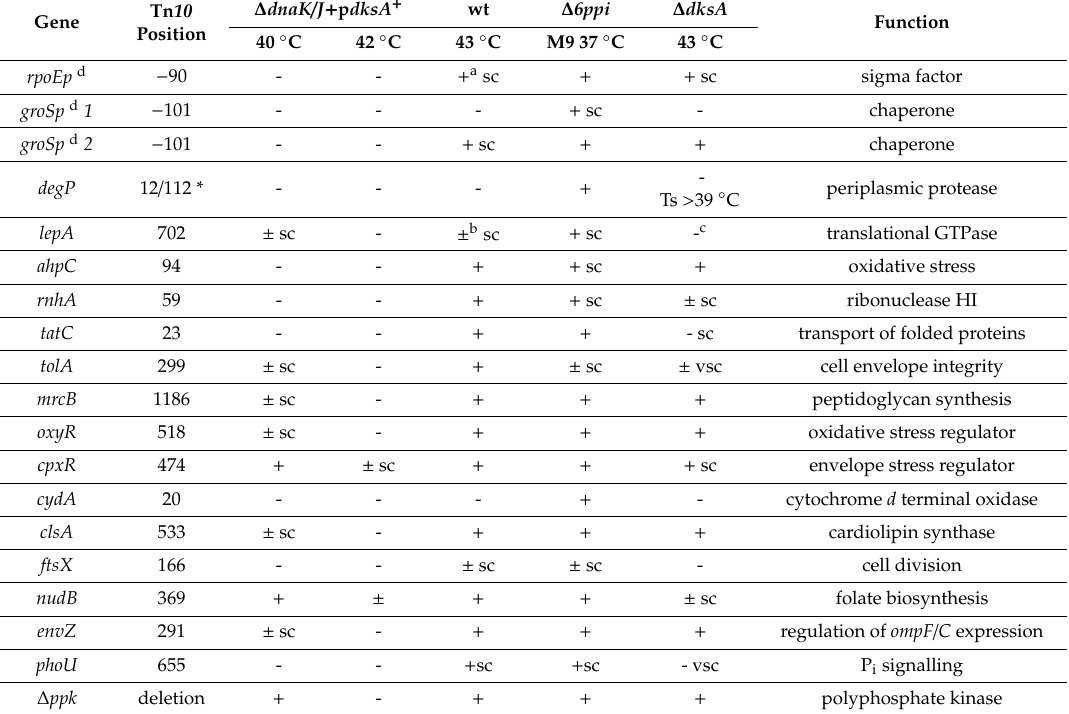
Table 6. Tn 10 insertions that block the multicopy suppression by DksA of ∆ 6 ppi , their suppression of ∆ dnaK / J strains as determined by colony forming units, the synthetic phenotype in the ∆ dksA background and the lack of ppk requirement for the DksA-mediated suppression of ∆ 6 ppi . Tn 10